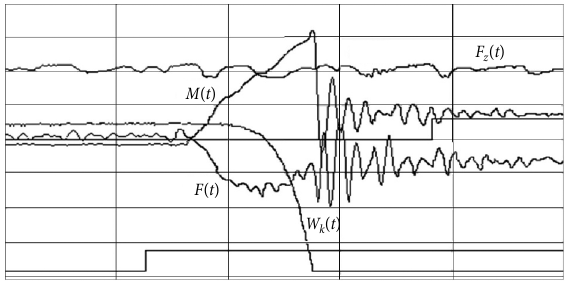
Fig. 12. Values F ( t ), M ( t ), F z ( t ) and w k ( t ) measured during measuring wheel braking (curves of dynamometer)